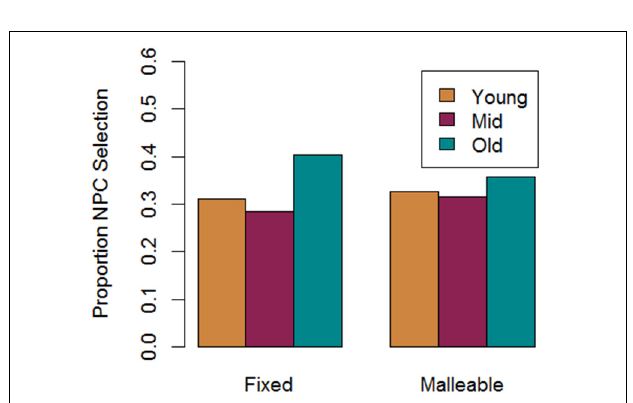
FIGURE 7 | Proportion of conversations for which different age category NPCs were